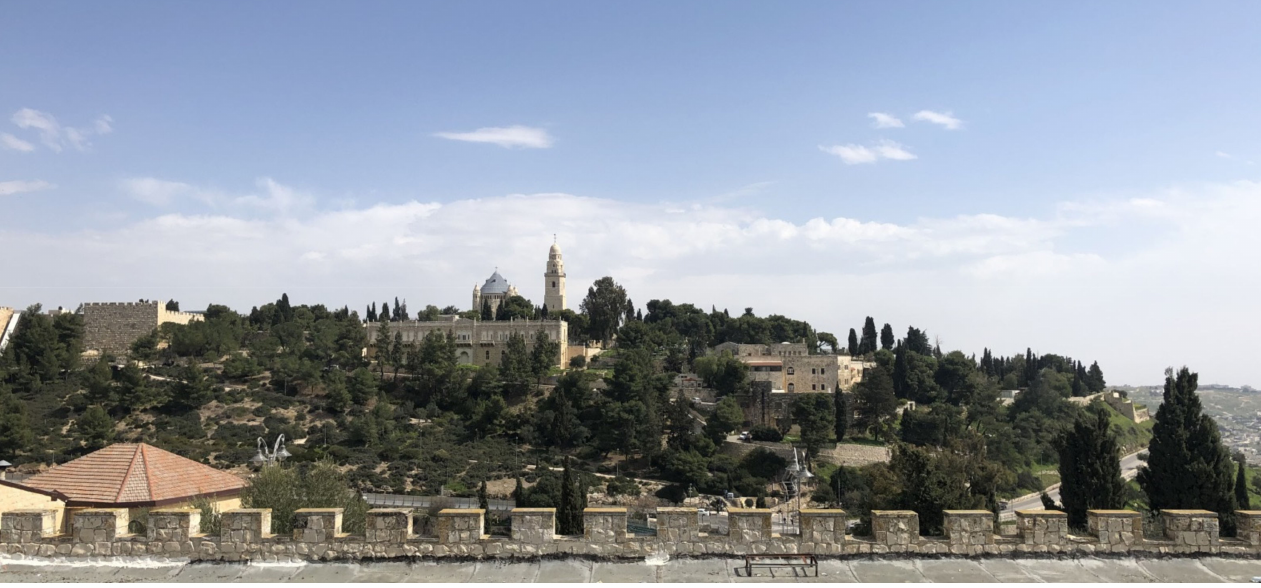
Figure 7. An exemplary intermediate west observation direction (K2) of the